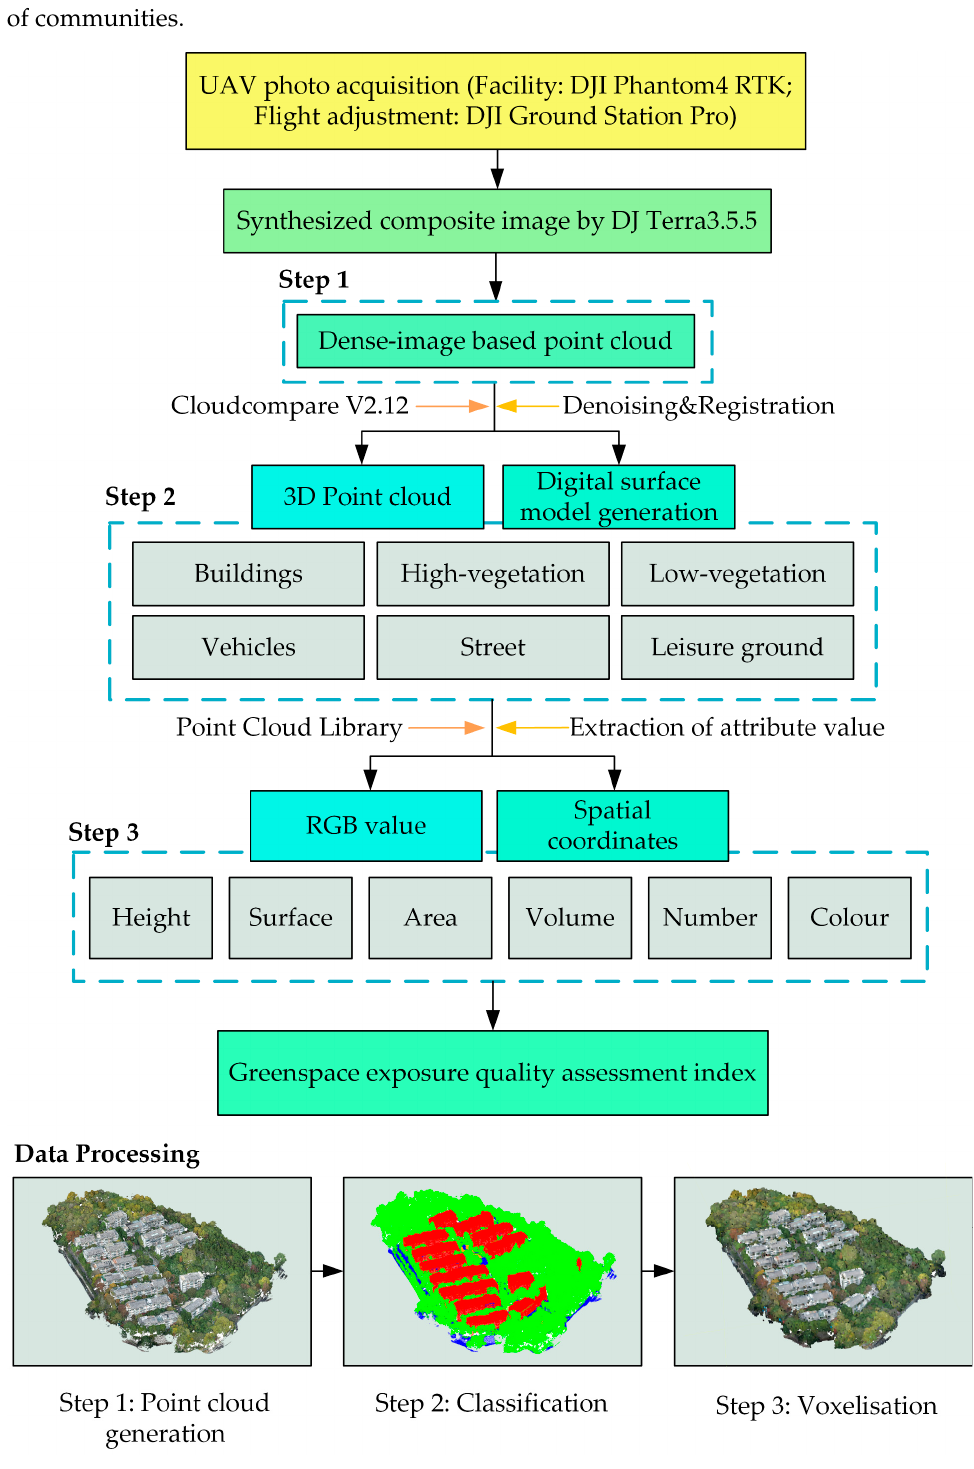
Figure 4. Workflow of the proposed method.